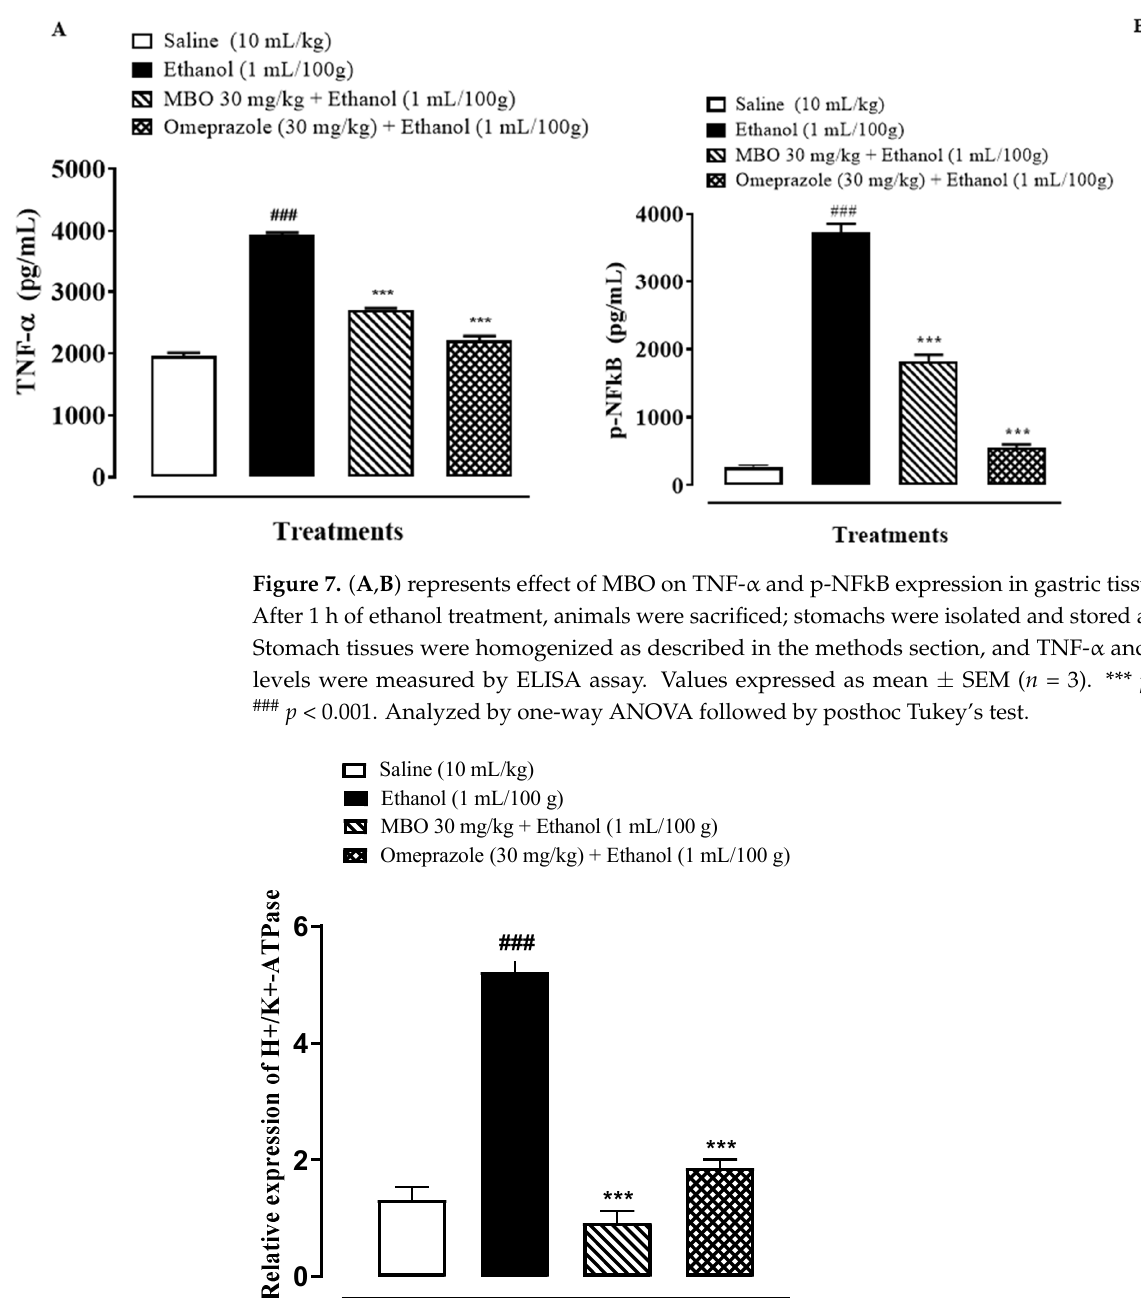
Figure 8. Effects of MBO in H + /K + -ATPase expression in ethanol-induced gastric ulcer model. The mRNA levels of H + /K + -ATPase were measured by RT-PCR using specific primers. Significance at *** p < 0.001 vs. ethanol group; ### p < 0.001 versus saline group. Analyzed by one-way ANOVA followed by posthoc Tukey’s